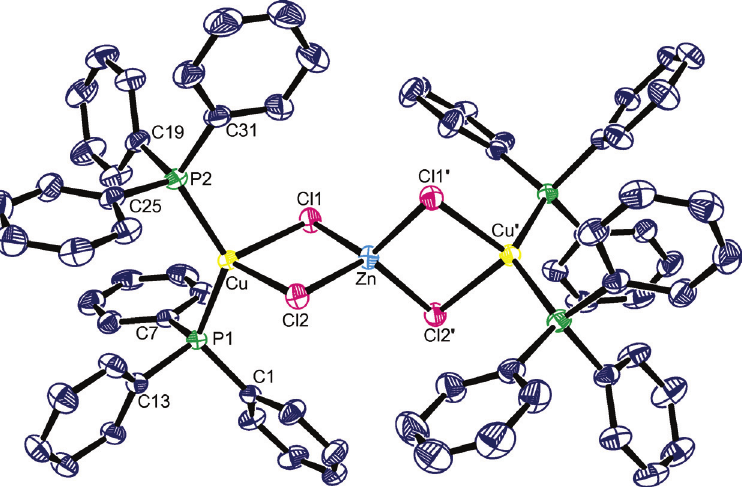
Figure 1 The asymmetric unit of 1 showing the labeling scheme used. Thermal ellipsoids are at the 40% probability level. Only the α -carbons of the phenyl rings are numbered for clarity; hydrogen atoms have also been omitted. Selected geometric data: Zn-Cl(1) 2.2709(5), Zn-Cl(2) 2.2902(5), Cu-Cl(1) 2.4555(5), Cu-Cl(2) 2.4535(5), Cu-P(1) 2.2539(5), Cu-P(2) 2.2522(5) Å; Cl(1)-Zn-Cl(2) 101.647(16), Cl(1)-Zn-Cl(1′) 105.56(3), Cl(1)-Zn-Cl(2′) 123.294(17), Cl(2)-Zn-Cl(2′) 103.28(3), P(1)-Cu-P(2) 129.91(2), P(1)-Cu-Cl(1) 106.773(19), P(1)-Cu-Cl(2) 107.548(18), P(2)-Cu-Cl(1) 105.860(19), P(2)-Cu-Cl(2) 108.077(19), Cl(1)-Cu-Cl(2) 92.154(16),